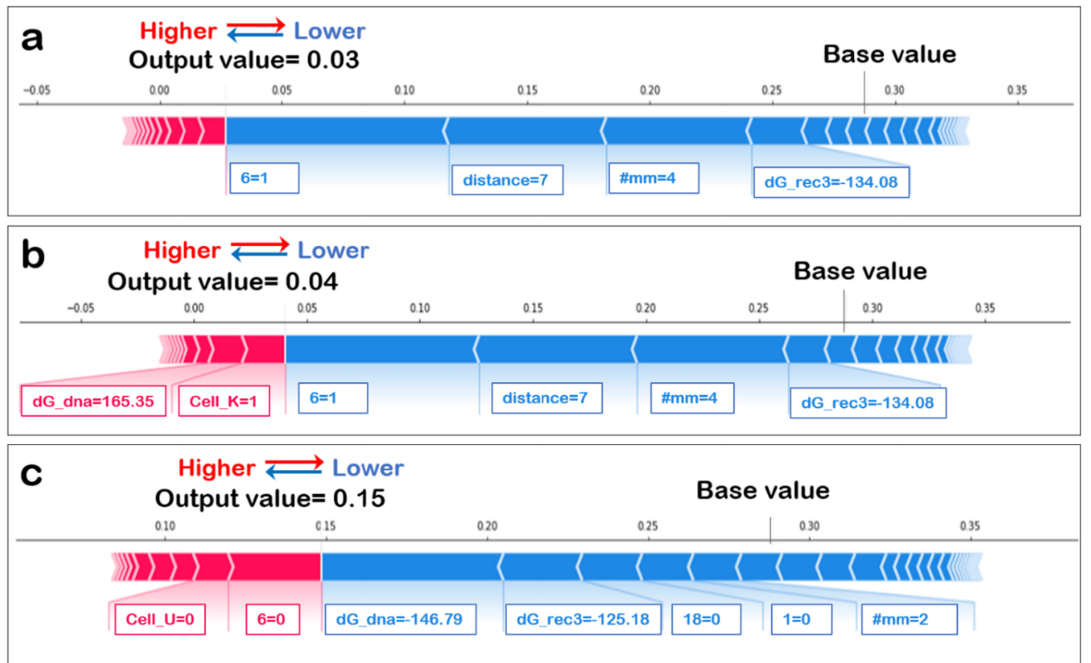
Figure 2. SHAP variable importance plot. The SHAP variable impact on outcome for singular datapoints are shown. Examples shown are explainer plots for dataset indices ( a ) 0, ( b ) 1 and ( c ) 2. The base value labelled in the figure in influenced by varying degrees by the features shown in the diagrams and the output value (shown in bold) was obtained. The features SHAP values are written alongside the features if it causes an increase in base value it is shown in red otherwise in blue.